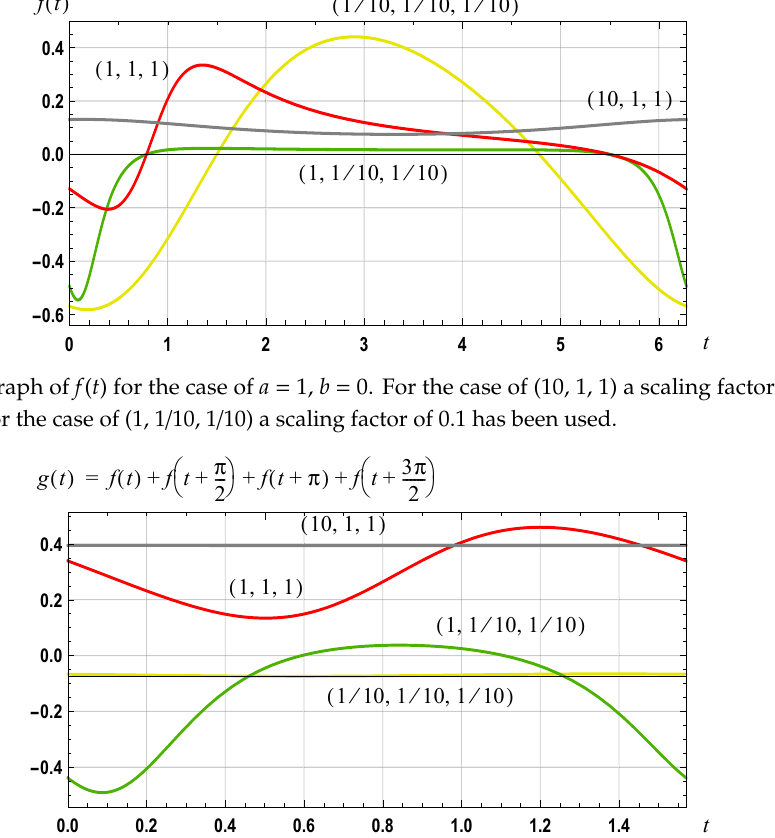
Figure 17. Graph of g ( t ). For the case of (10, 1, 1) a scaling factor of 10 has been used; for the case of (1, 1 / 10, 1 / 10) a scaling factor of 0.1 has been used.